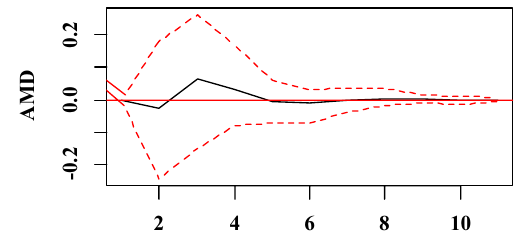
Fig. 5 Results of generating the AMD series in test step using VAR- GARCH model